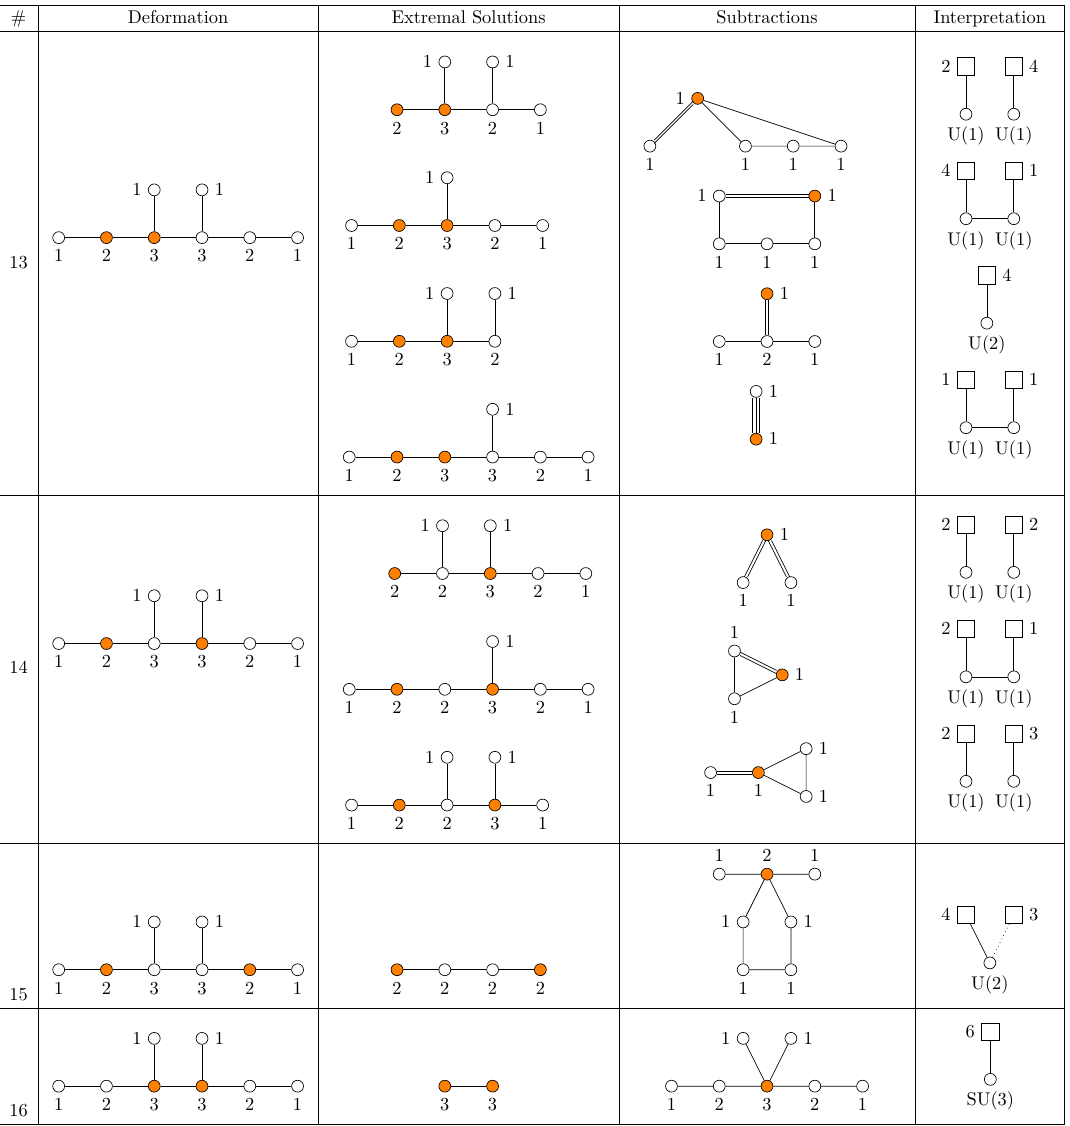
Table 5 . Analysis for SU(3) with 7 flavors (3/3). The first column specifies the FI deformation, the second column shows the extremal solutions and the third column gives the result of the subtraction. The last column gives a 3d